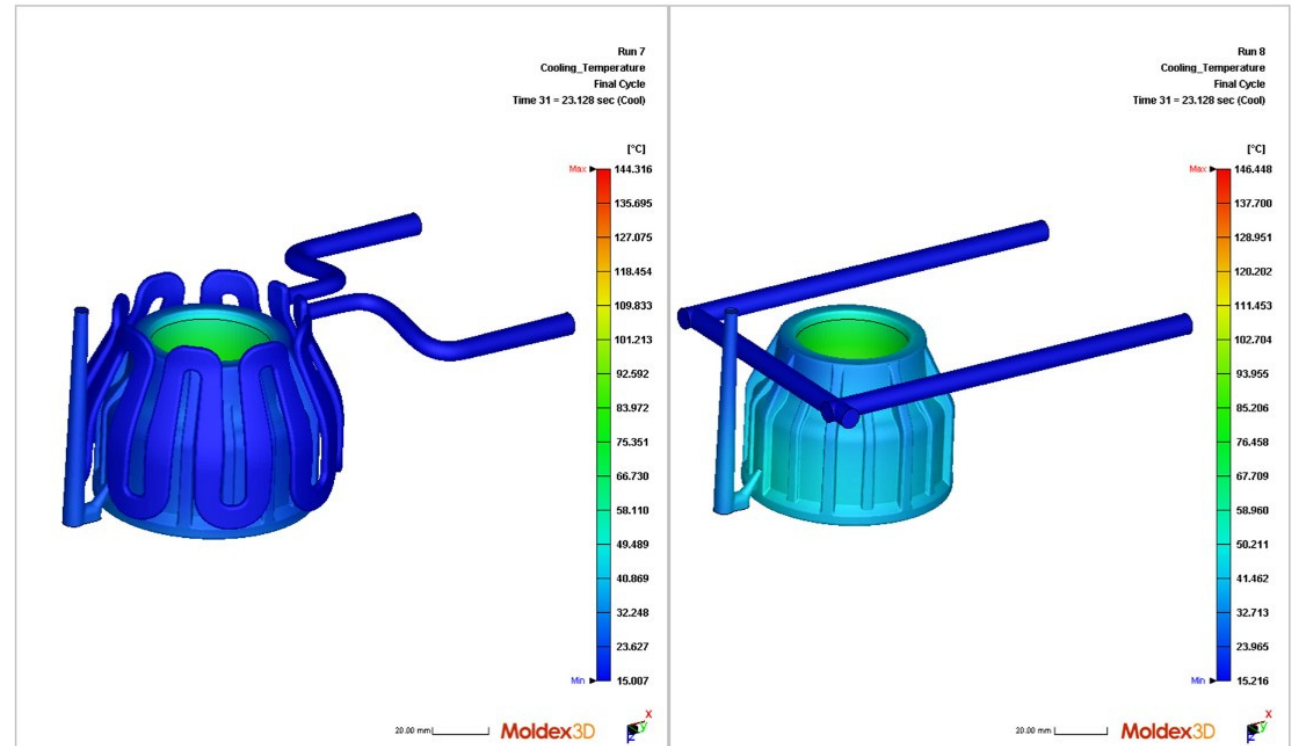
Figure 3. Process temperature reduction in injection molded cap surface with utilization of crown conformal cooling channels calculated by means of transient thermo-mechanical finite element (FE) model with the aid of the software Moldex3D at 23 s, completion of injection phase with conformal cooling ( left ) compared to conventional cooling ( right ), by Papadakis et al. [28].